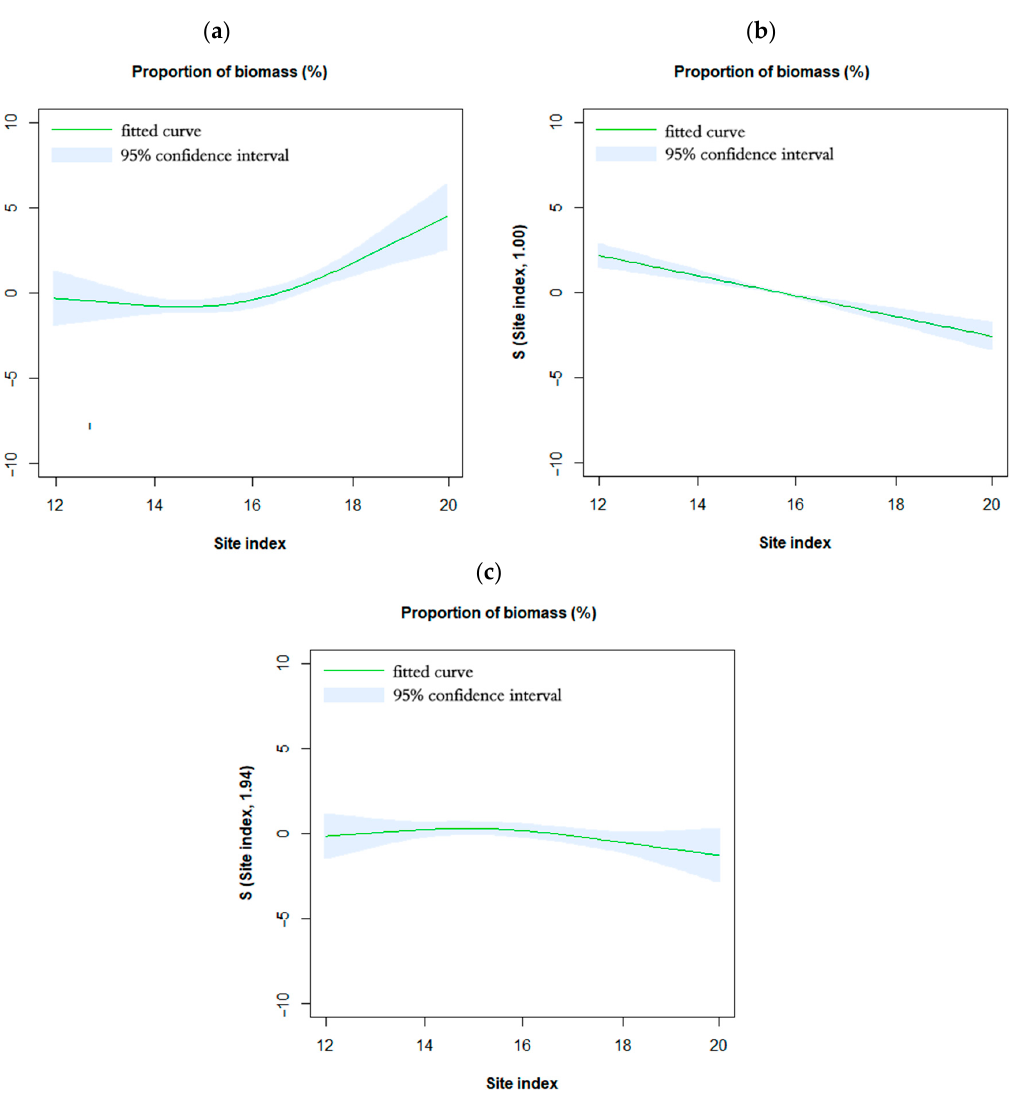
Figure 4. Observed effects of site quality on the proportion of biomass of different tree organs in GAMM. ( a ) Stem, ( b ) bark, and ( c ) branches. The S () of the vertical axis represents the smooth spline functions; The numbers in brackets represent the estimated degrees of freedom with smooth spline functions, 1 represents linearity, greater than 1 represents nonlinearity, and the larger the number, the stronger the nonlinearity.